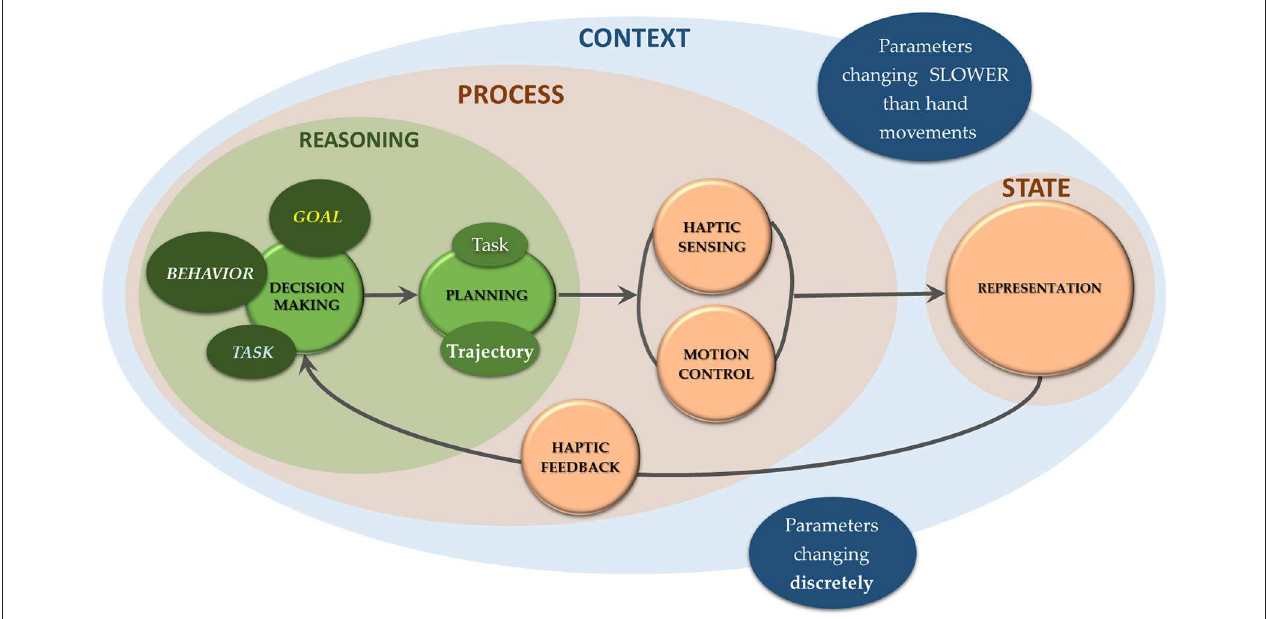
FIGURE 1 | The closed-loop sensorimotor control of robots for touch is intended as a sequence of system states , represented through features. The process step includes all dynamical processes in-between two states and it is enabled by haptic feedback . This step includes a reasoning stage in which choices are made on how to move ( decision making and planning ), and a controlled haptic sensing -while- moving stage to acquire sensor data to be processed for system representation. Motion commands are tailored to prevailing movement contexts , defined by discrete or slowly changing parameters with respect to the movements for touch (Wolpert and Ghahramani,